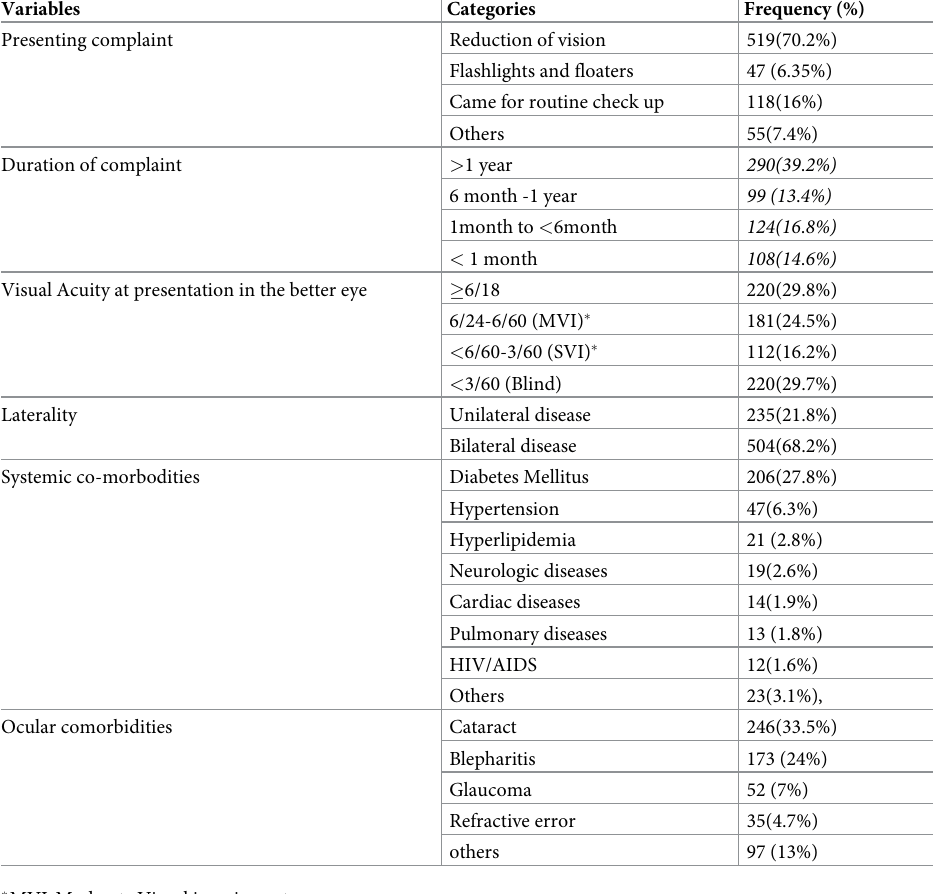
Table 2. Clinical characteristics of patients with vitreo-retinal diseases presented to the University of Gondar Ter- tiary eye care and training center vitreoretina clinic, NW Ethiopia. (n =